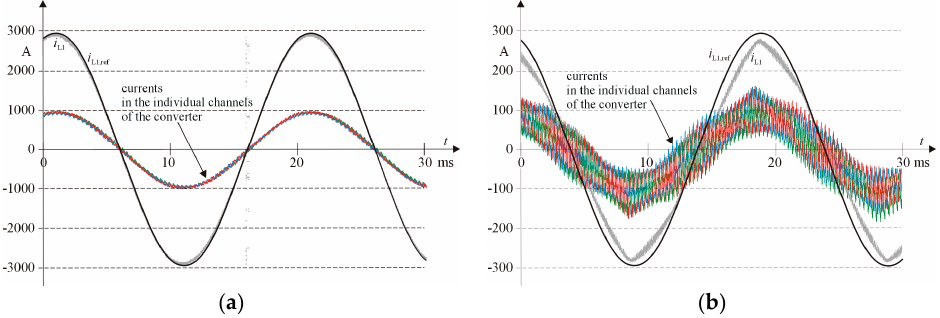
Figure 11. Waveforms of currents in individual inverter channels, reference grid current (black), and